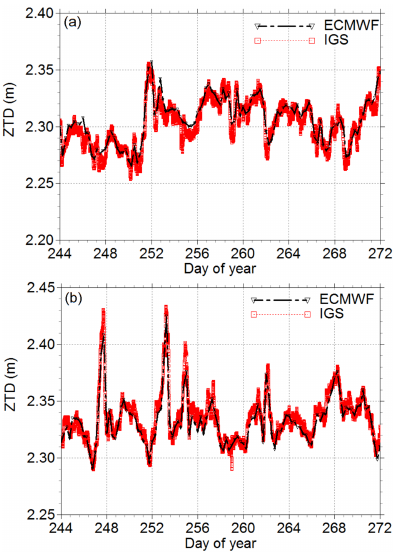
Figure 2. The time series of ECMWF and IGS ZTDs at stations KIRU (a) and NNOR (b) for September (day of year, DOY, 244– 272) 2015. The ECMWF ZTDs are shown by black triangles, while the IGS ZTDs are displayed by red squares.